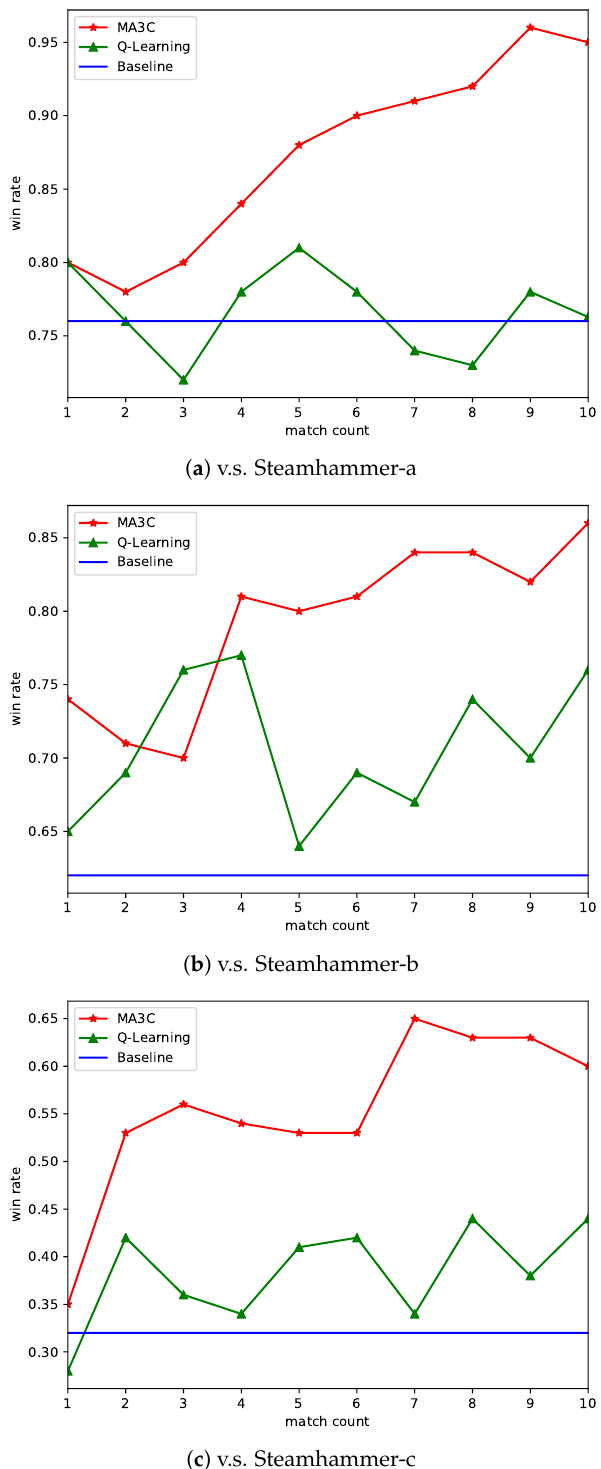
Figure 7. The win rate of each 100 matches over time in the training process. Comparing with Q- learning method, MA3C significantly improves the performance. Against the weaker two opponents, MA3C achieves very high rate of winning, about 90%. For the hardest case, the learned policy still improves win rate about